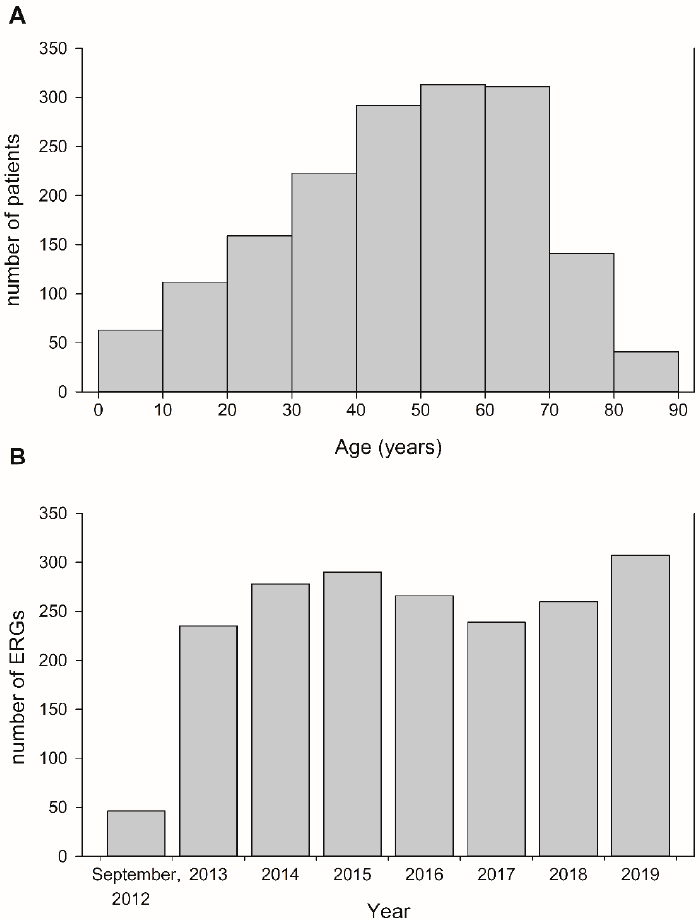
Figure 1. ( A ) Distribution of patients’ ages when receiving their first ffERG during the study period. ( B ) Cumulative number of ffERG examinations per year in this single tertiary medical center.